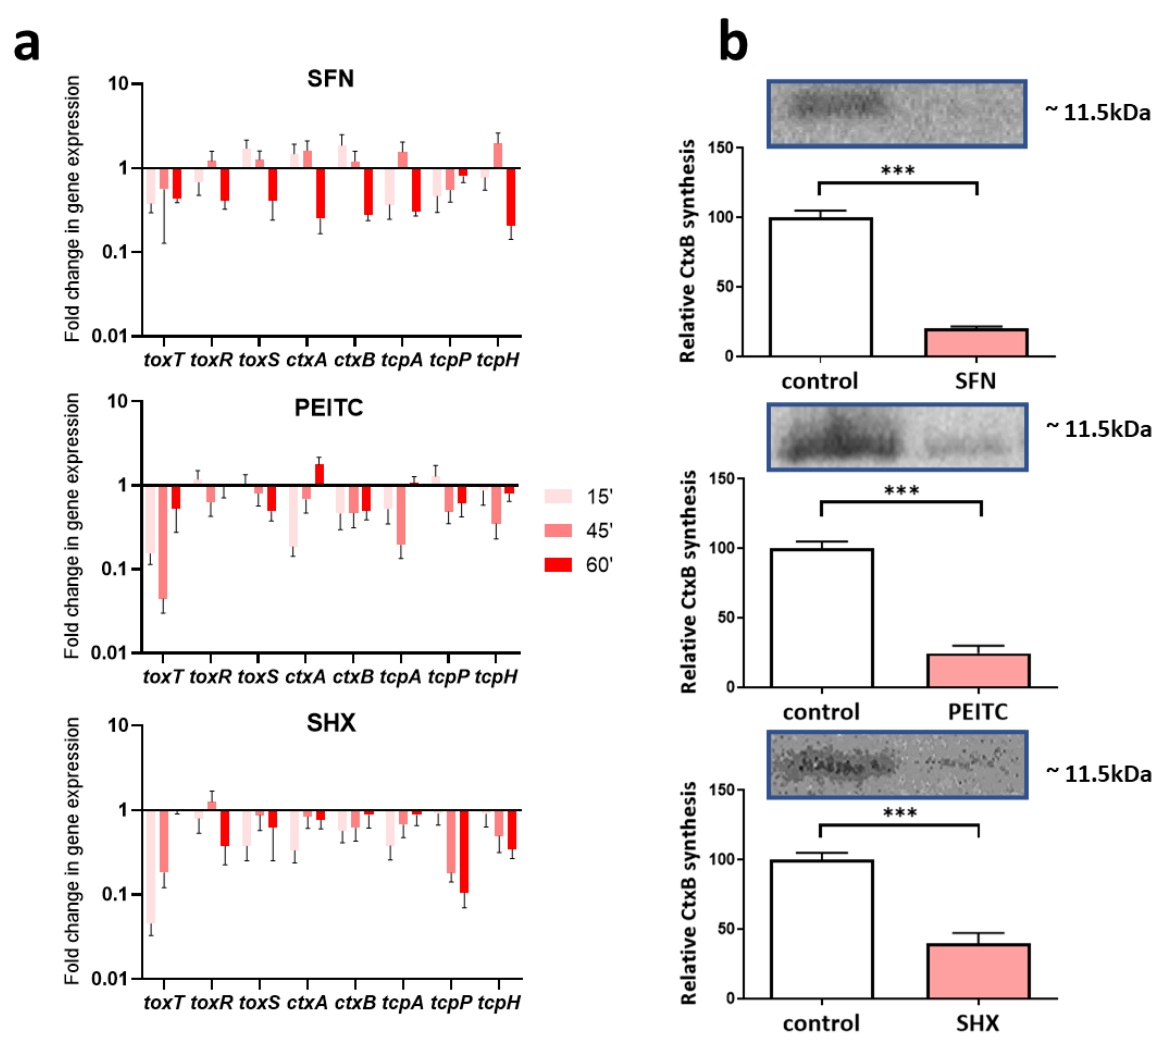
Figure 4. The expression of V. cholerae virulence factors is decreased by ITC treatment. ( a ) The genes’ expression was assessed using RT-qPCR method. Transcriptional levels of various virulence-related genes were analyzed by qRT-PCR in the stringent response inducing conditions, namely treatment with SFN (¼ MIC), PEITC (1/8 MIC), SHX (0.8 mg/mL) for 15, 45, and 60 min at 37 °C. The relative transcription level of each gene was compared to the recA gene used as an internal control. ΔΔCt was calculated as: ΔCt (test)−ΔCt (calibrator). Ratio= efficiency −ΔΔCt . ( b ) CT protein was detected by Western blot using anti-CTB rabbit monoclonal antibodies. Samples were collected after 20 h. Toxin production was quantified densitometrically by the Quantity One (Bio-Rad). The results presented are mean values from 3 independent experiments. The Student ’ s t -test statistical significance is marked with asterisks, *** p < 0.001.